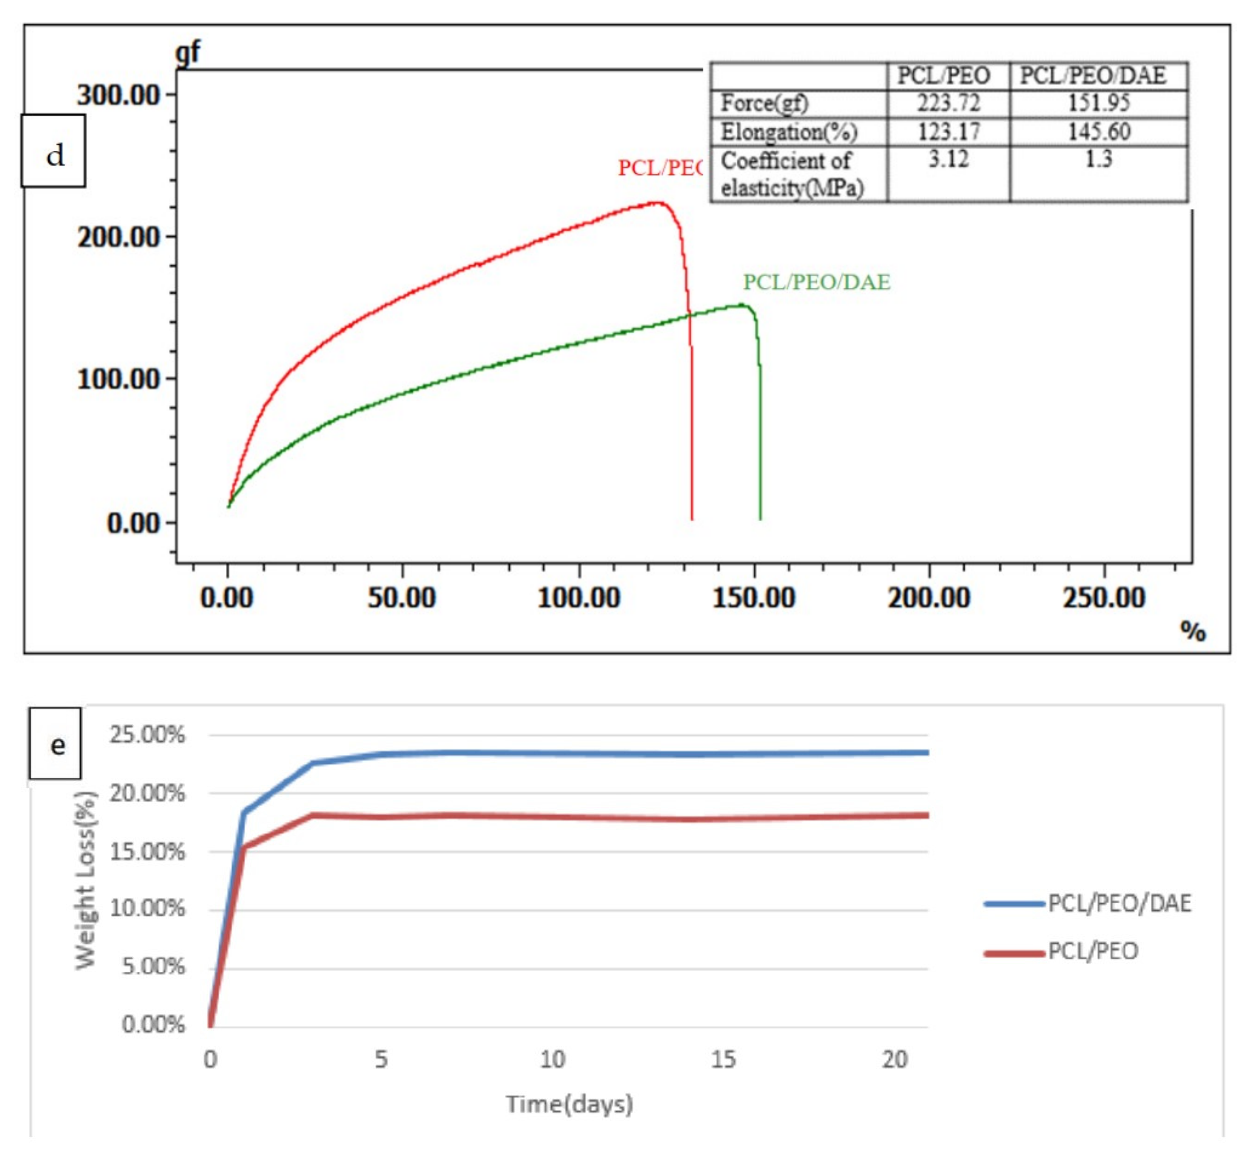
Figure 7. FTIR analysis of various nanofibers and DAE ( a ), the swelling ratio ( b ), porosity ( c ), mechanical property ( d ), and biodegradation rate ( e ) of the two nanofibers. Values are expressed as mean ± SD (n = 3), * p < 0.05 compared with PCL/PEO group.